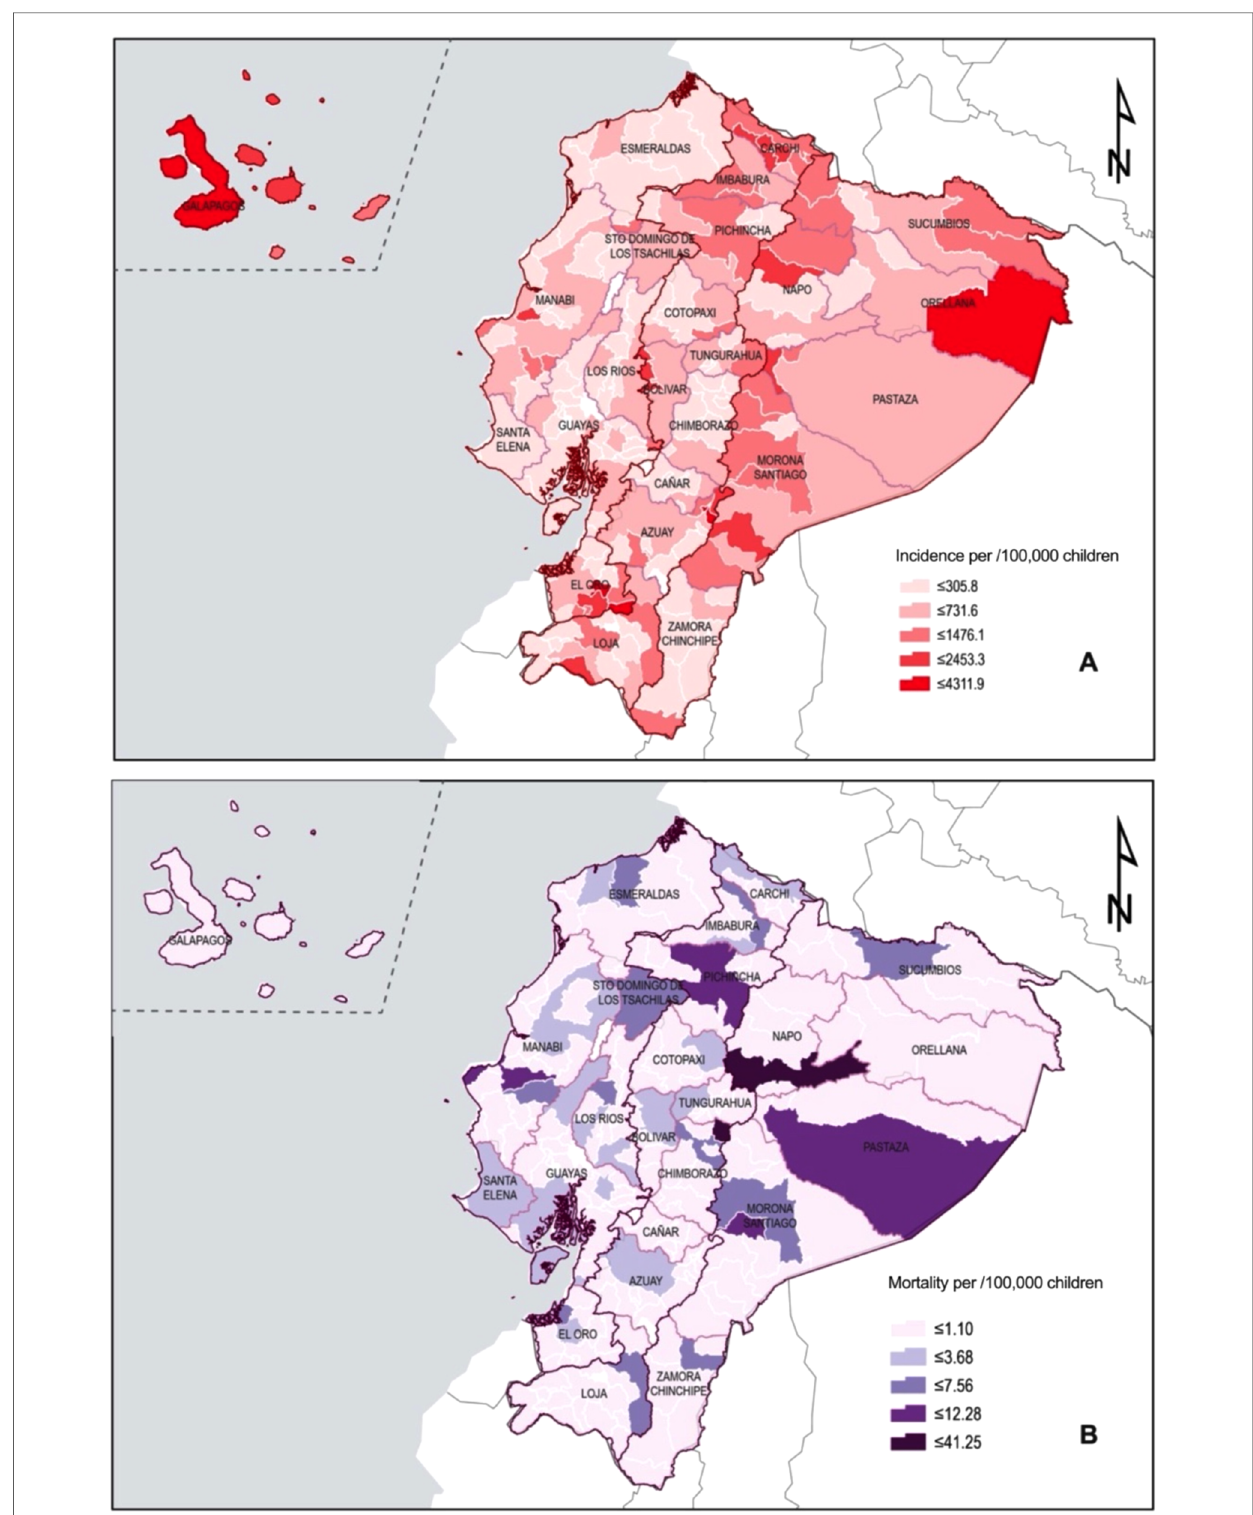
FIGURE 3 Geographic distribution of COVID-19 cases and deaths among Ecuadorian children. ( A ) Incidence rate by cantons. ( B ) Mortality rate by